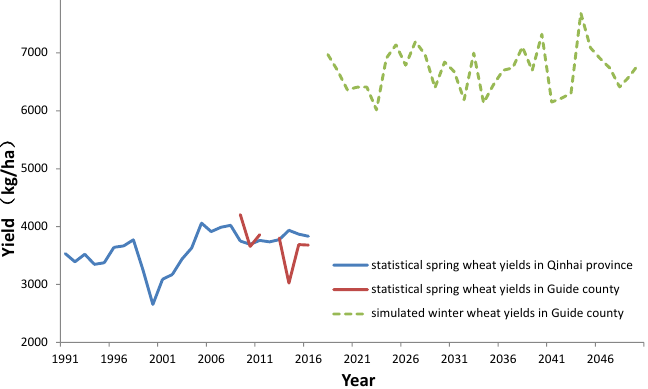
Figure 6. The change of spring wheat yields in the Qinghai province (1991 – 2016), Guide county (2009 – 2016), and simulated winter wheat potential yields (2018 – 2050).